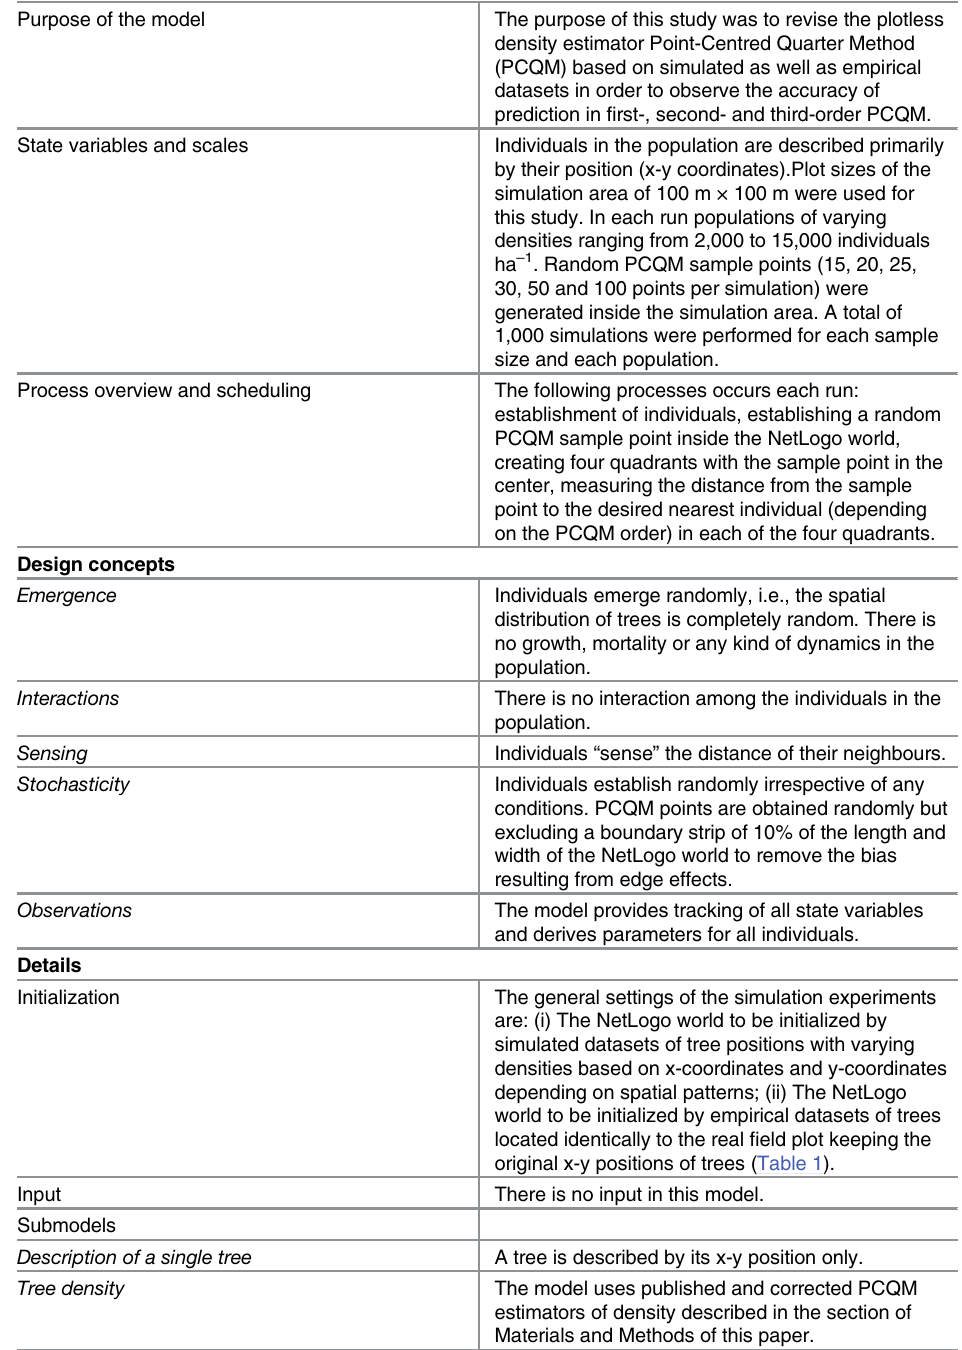
Table 2. Model description following the ODD protocol [28 –